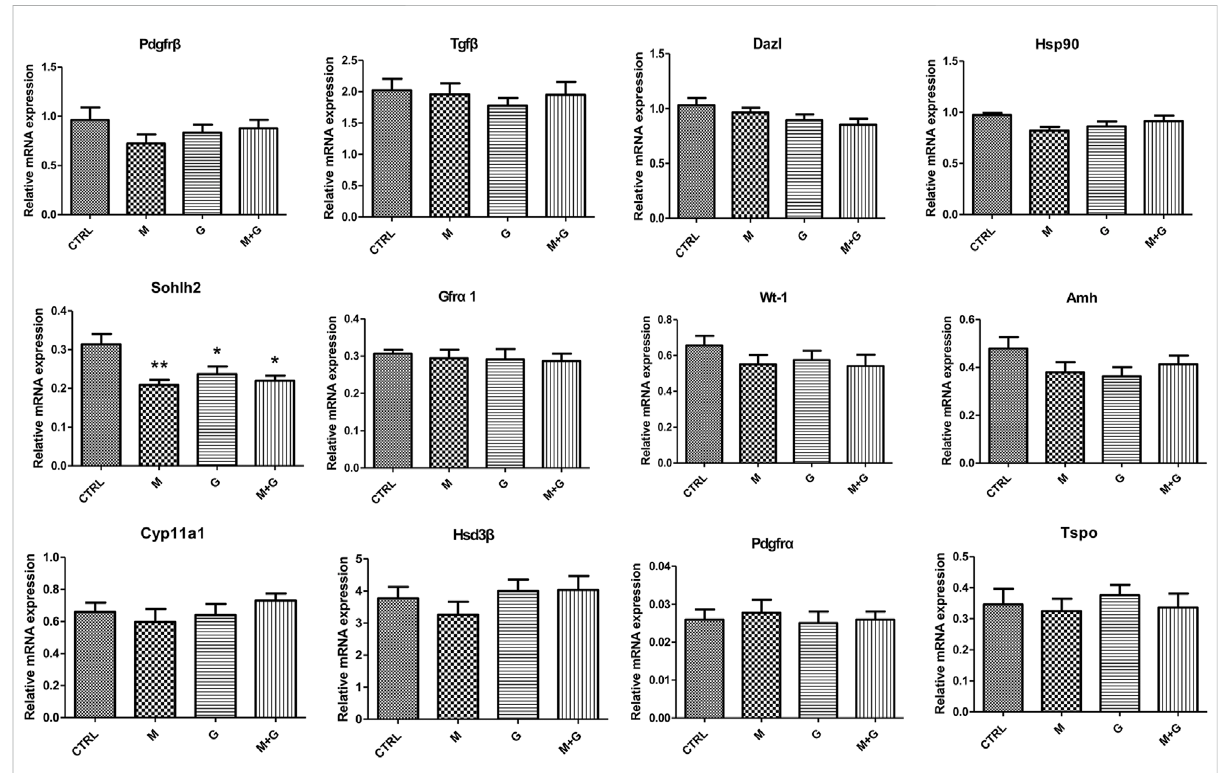
FIGURE 5 Gene expression of fetal germ cell, Sertoli cell and Leydig cell markers. *, signi fi cantly different from CTRL at p < 0.05; **, signi fi cantly different from CTRL at p < 0.01.